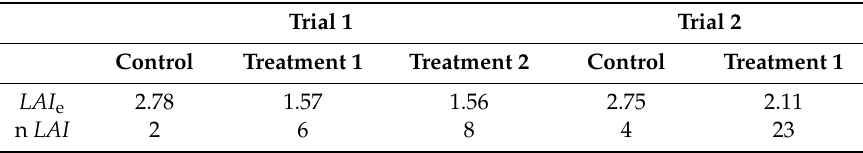
Table 2. Mean LAI e field measurements for the different treatments in Trials 1 and 2. Trial 1 Trial 2 Control Treatment 1 Treatment 2 n LAI : number of LAI plots, LAI e: Effective leaf area index.